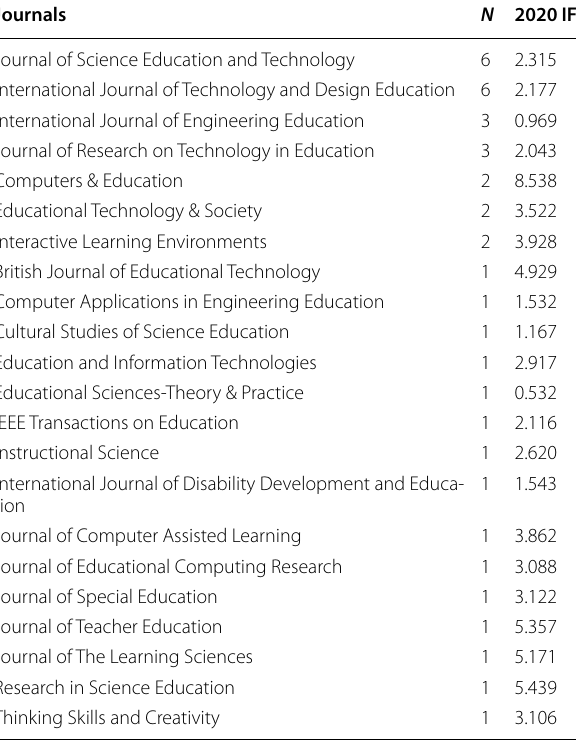
Table 2 Journals publishing articles on R‑STEM